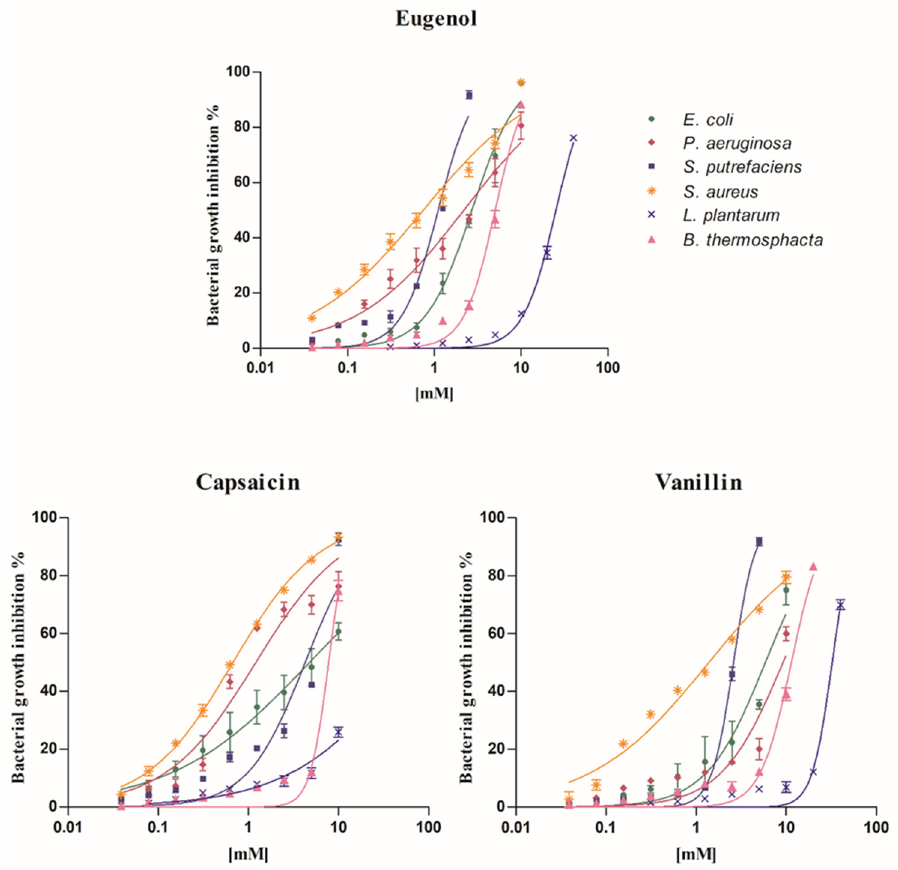
Figure 1. Concentration/response curves. Concentration/response curves of eugenol, capsaicin, and vanillin on E. coli , P. aeruginosa , S. putrefaciens , S. aureus , L. plantarum , and B. thermosphacta in the microbial susceptibility test. The trends are from the interpolation of three independent experiments, using GraphPad Prism 5 ((GraphPad Inc., San Diego, CA, USA). The bars represent the standard deviation.